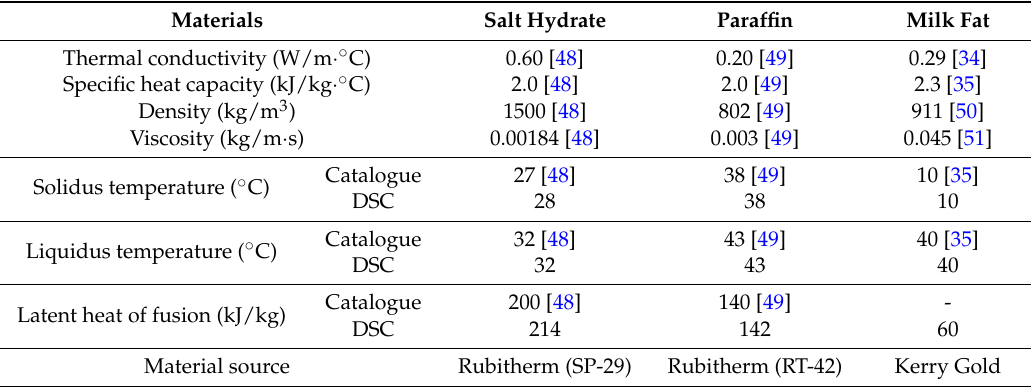
Table 4. Thermo-Physical properties of phase change materials (PCMs) characterized by differential scanning calorimetry